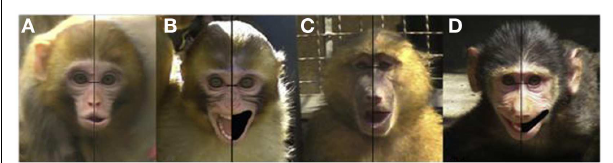
FIGURE 4 | Examples of asymmetries in expressions in infant macaques [(A) cooing; (B) screaming] and infant baboons [(C) moaning; (D) gecking] (Reprinted fromWallez andVauclair, 2012, Copyright with permission from Elsevier)